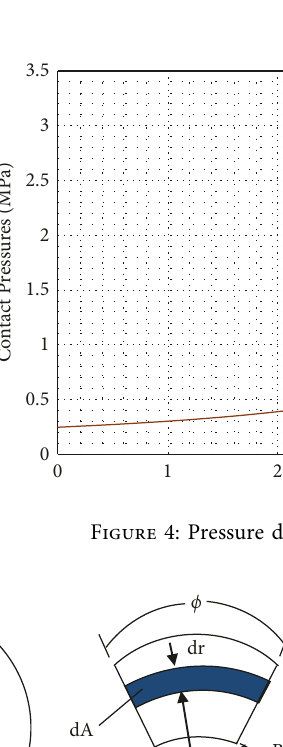
Figure 3: Boundary conditions of the disk. (a) Uniform wear and (b) uniform pressure.